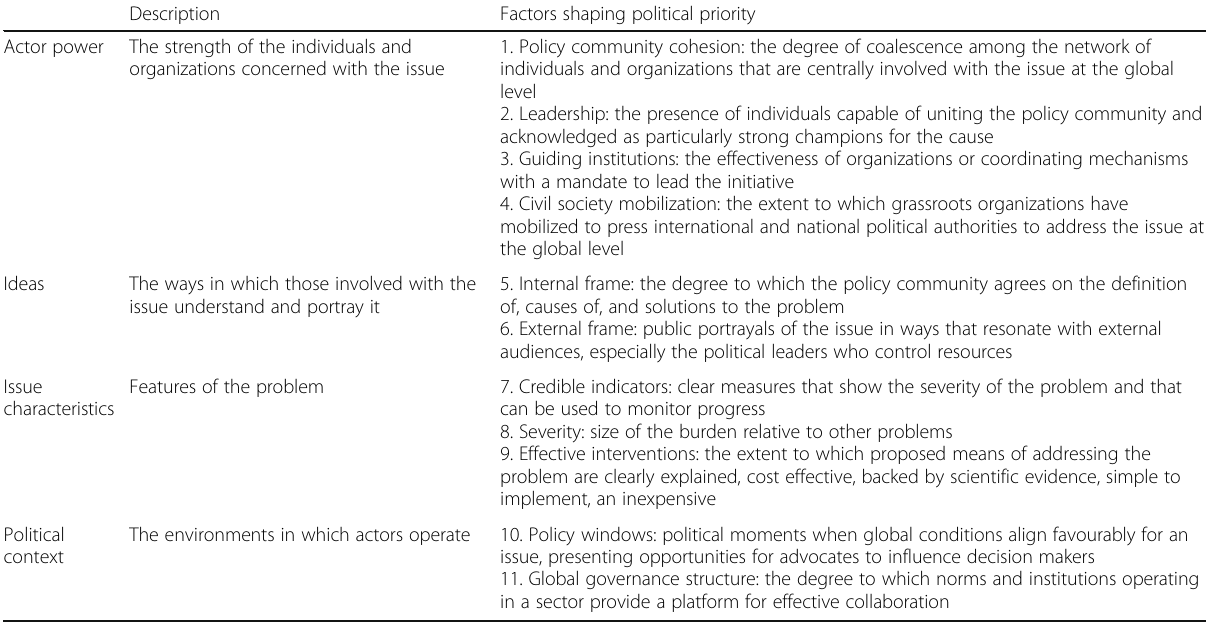
Table 1 Shiffman and Smith ’ s Framework